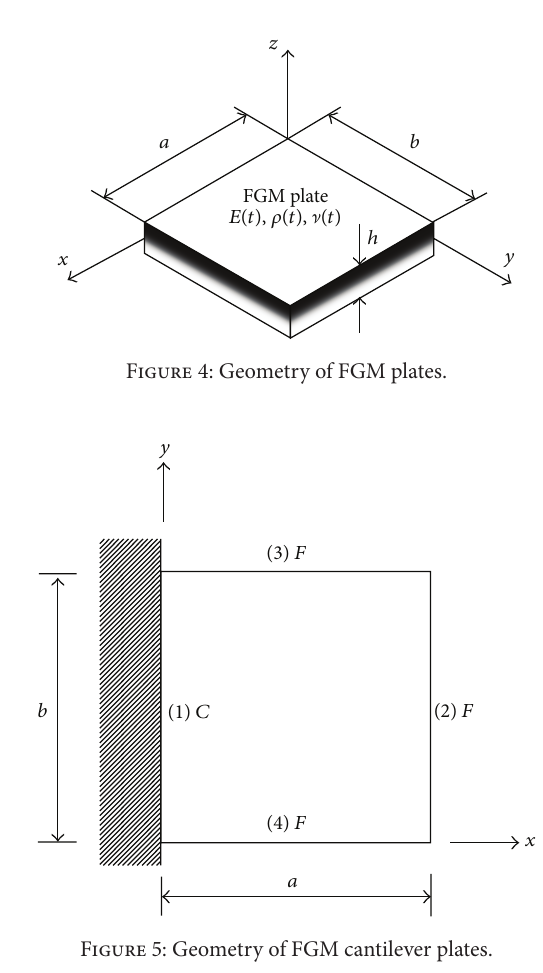
Figure 5: Geometry of FGM cantilever plates.